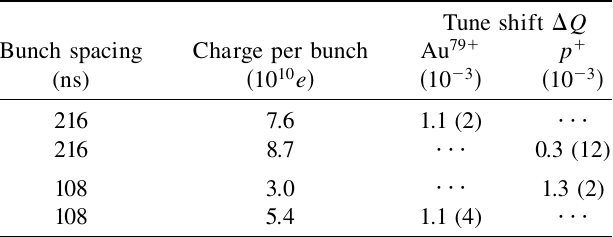
TABLE II. Measured coherent tune shifts (cid:21) Q along bunch trains. The values given are the difference in tune between bunch 55 and bunch 1 and are averaged over the horizontal and vertical tune shifts. The number of measurements is shown in parentheses.